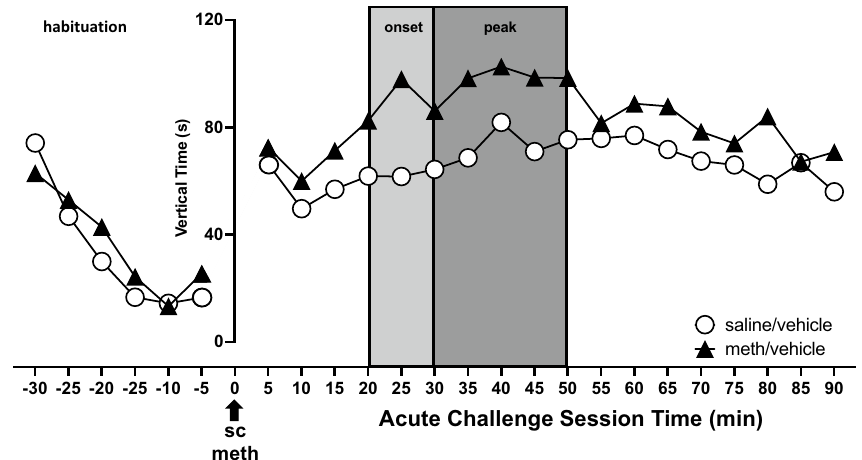
Figure 4. Graphical representation of the response to an acute challenge of methamphetamine (meth). There was no difference in the habituation profile. Shaded boxed indicate the time frames analyzed for onset and peak phases. Error bars were omitted for clarity. Re-label the x-axis as “Time (min) from Meth Acute